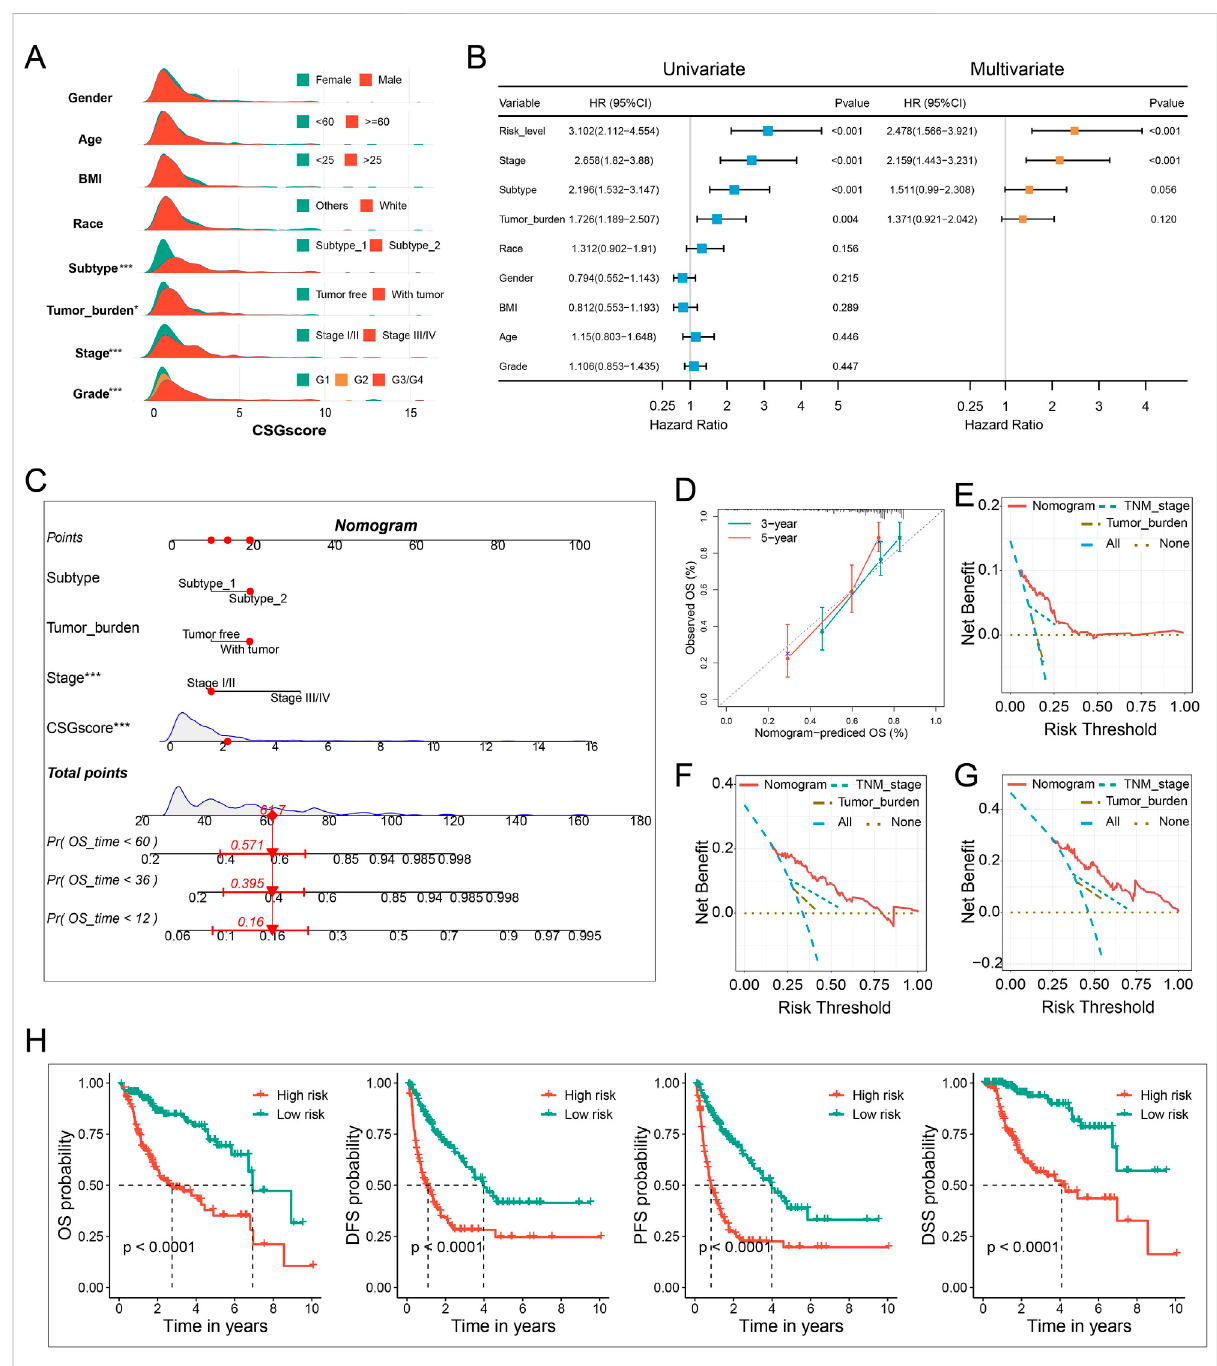
FIGURE 7 Integration of clinicopathologic characteristics and CSGscore to construct the nomogram. (A) Comparison of CSGscore distribution based on clinicopathologic parameters using the whole TCGA cohort. (B) Univariate and multivariate analysis of CSGscore and other clinicopathologic traits based on the whole TCGA cohort. (C) The CSGscore-integrated nomogram. (D) Calibration curves of the nomogram. (E – G) Decision curve analysis (DCA) plot of the nomogram for 1-year (E) , 3-year (F) , and 5-year (G) OS prediction. (H) Kaplan-Meier curves of thenomogram for the OS, DFS, PFS, and DSS of HCC. * p < 0.05, ** p < 0.01, *** p < 0.001, and ns indicates no signi fi